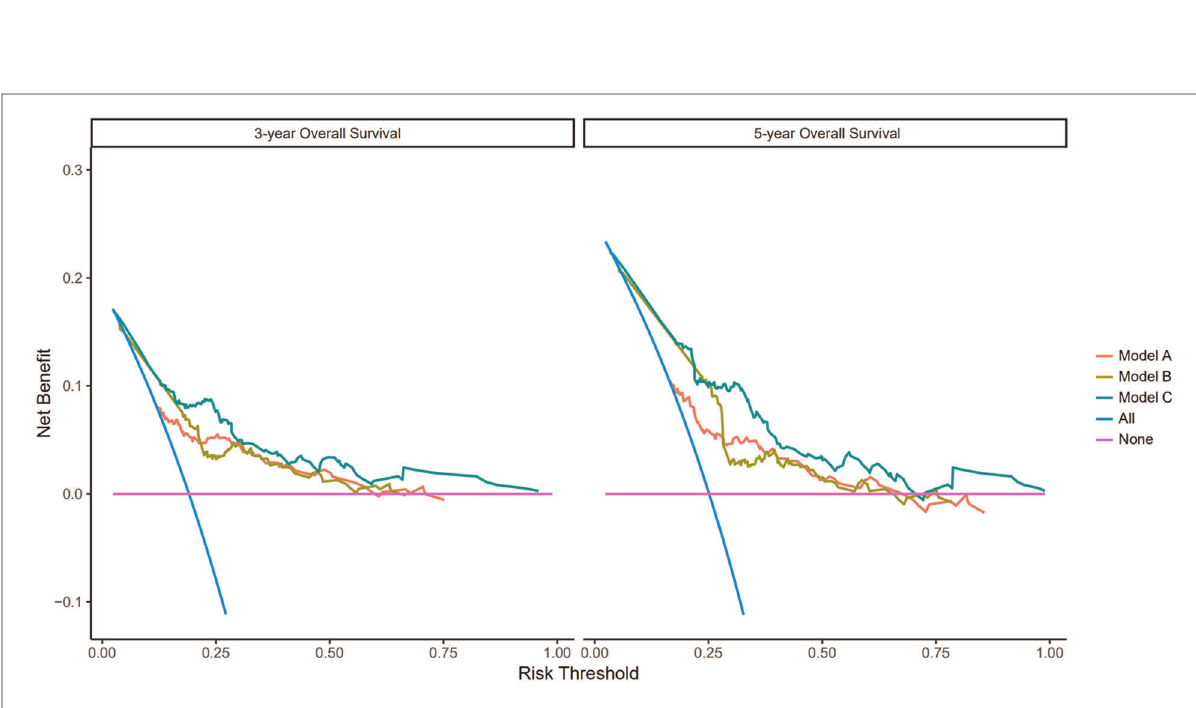
FIGURE 4 Prediction ability of the pTNM, no PNI-nomogram, and nomogram model for intensive overall survival (OS) of patients undergoing enhanced recovery after surgery (ERAS) combined with robotic radical gastrectomy in the training set. Decision curve analysis of 3- and 5-year OS of patients in the training set. The X -axis indicates the threshold probability for OS of patients undergoing enhanced recovery after surgery (ERAS) combined with robotic radical gastrectomy and the Y -axis indicates the net bene fi t. Compared to the pTNM, non PNI-nomogram, and nomogram model, the net bene fi t for the nomogram model was larger over the range of clinical threshold. [Model ( A ): the pTNM model; Model ( B ): the non PNI-nomogram model; Model ( C ): the nomogram model]. Abbreviations: AUC, area under the curve; PNI, prognostic nutrition index; pTNM, pathological